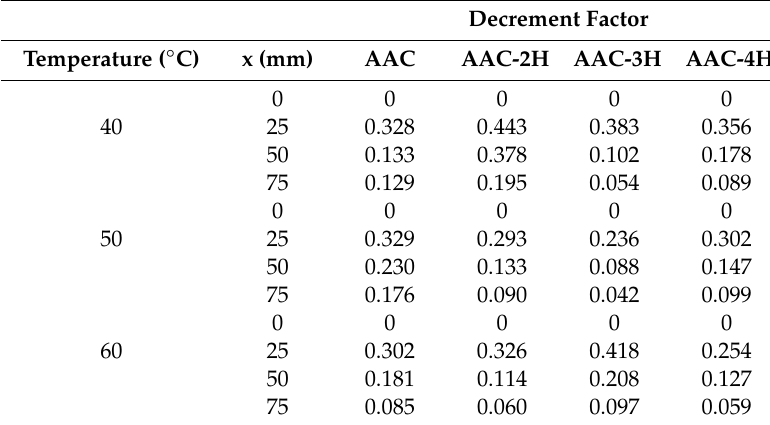
Table 2. Average decrement factor of AAC.